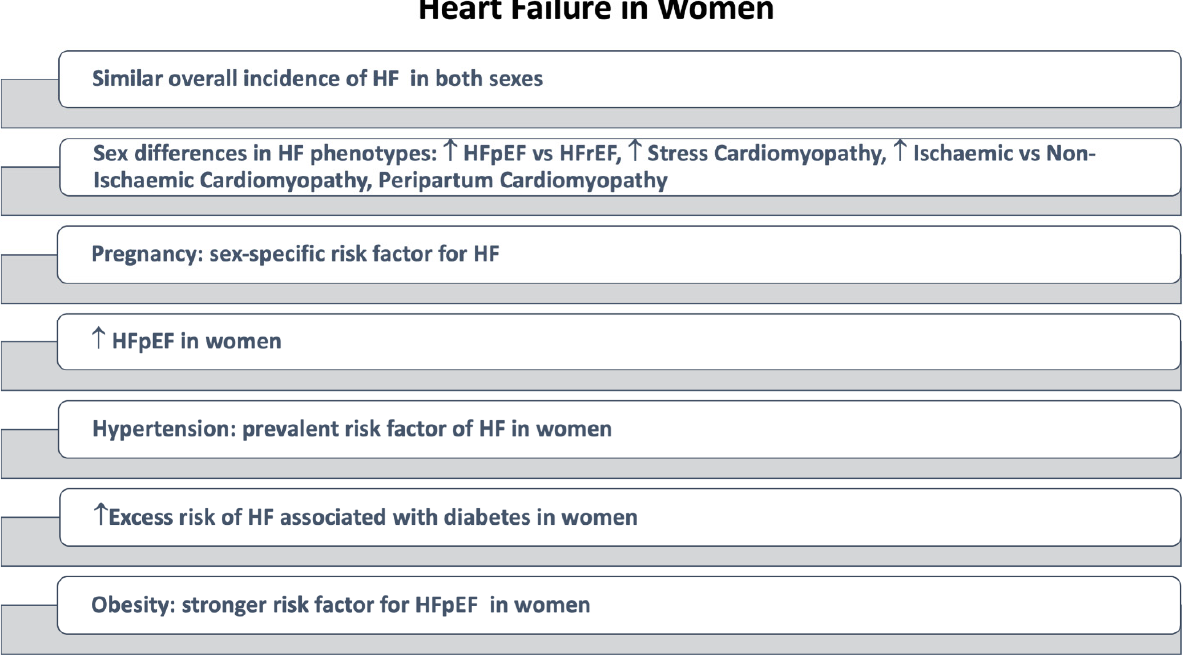
Figure 4. Heart Failure in Women. Abbreviations: HF: Heart Failure, HFpEF: Heart Failure with preserved ejection fraction; HFrEF: Heart failure with reduced ejection fraction.